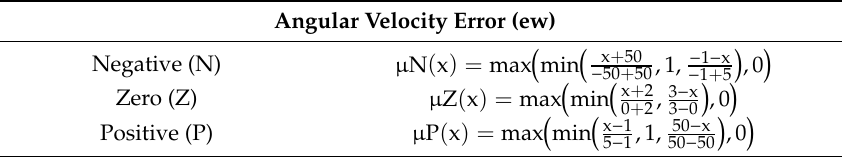
Table 6. Mathematical representation of the input 2 membership function.